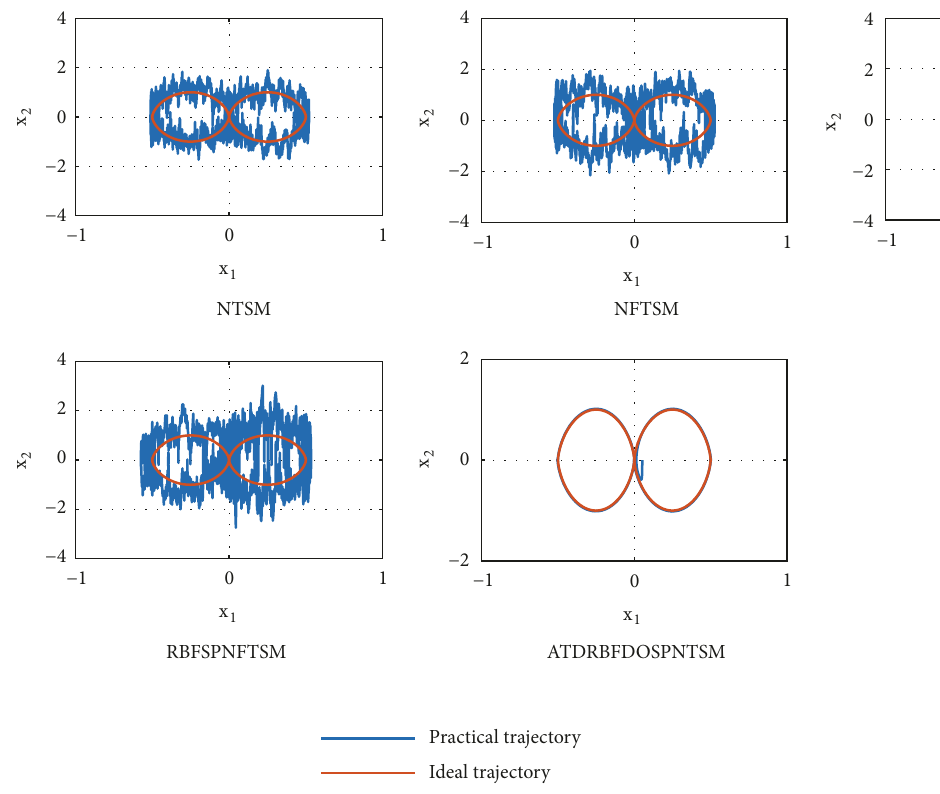
Figure 14: System phase trajectory curve (adding